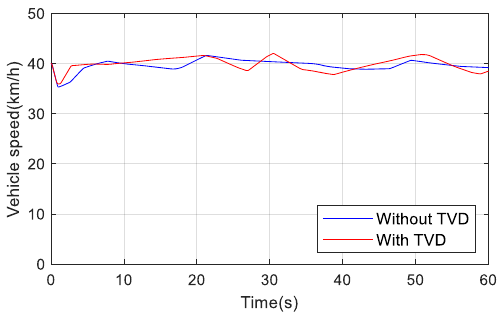
Figure 10. Curves of vehicle speed.